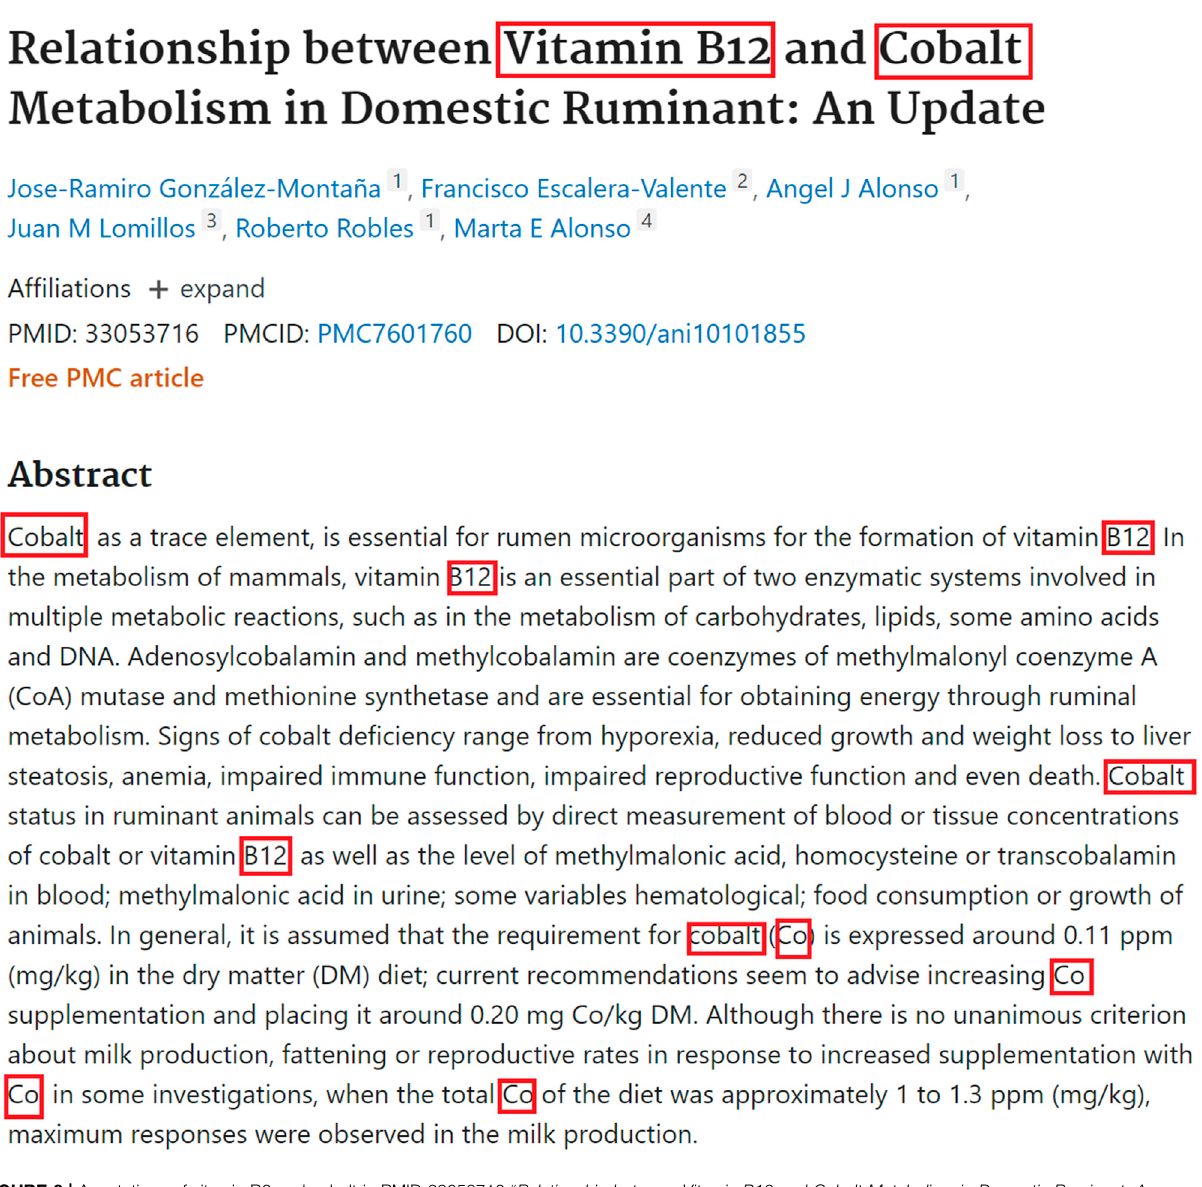
FIGURE 8 | Annotations of vitamin B2 and cobalt in PMID 33053716 “ Relationship between Vitamin B12 and Cobalt Metabolism in Domestic Ruminant: An Update ” .